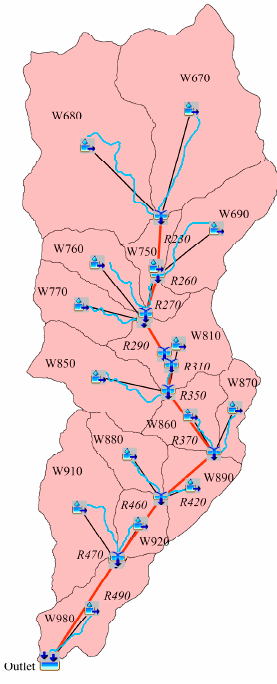
Figure 4. Spatial distribution of 15 sub-watersheds and main river branches in the red line. Table 3. Statistical description of the 15 sub-watersheds and main river branches.